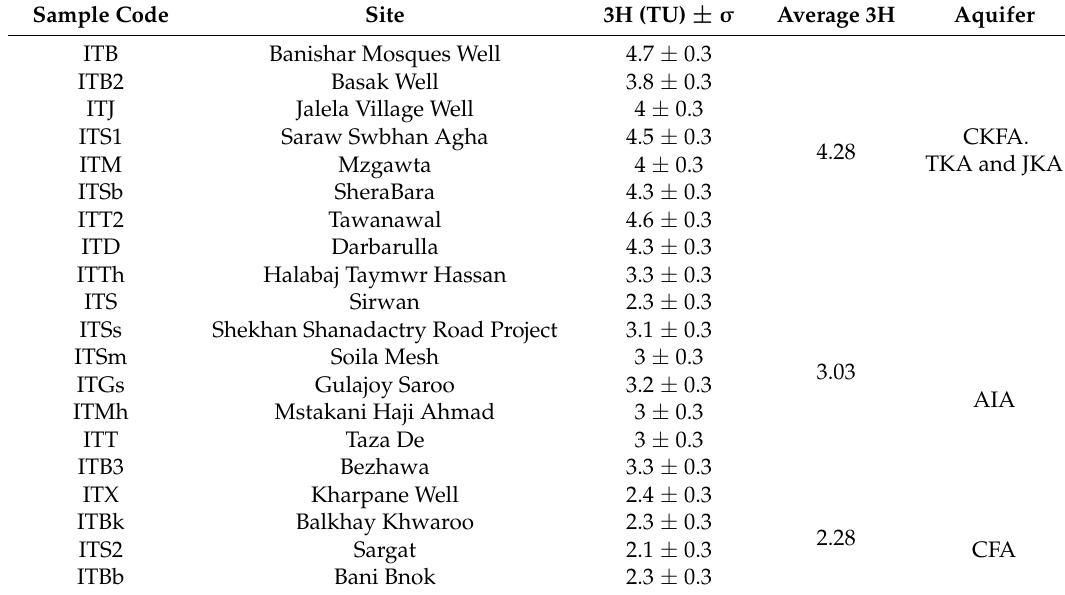
Table 5. Results of Trituim analysis of groundwater samples in the